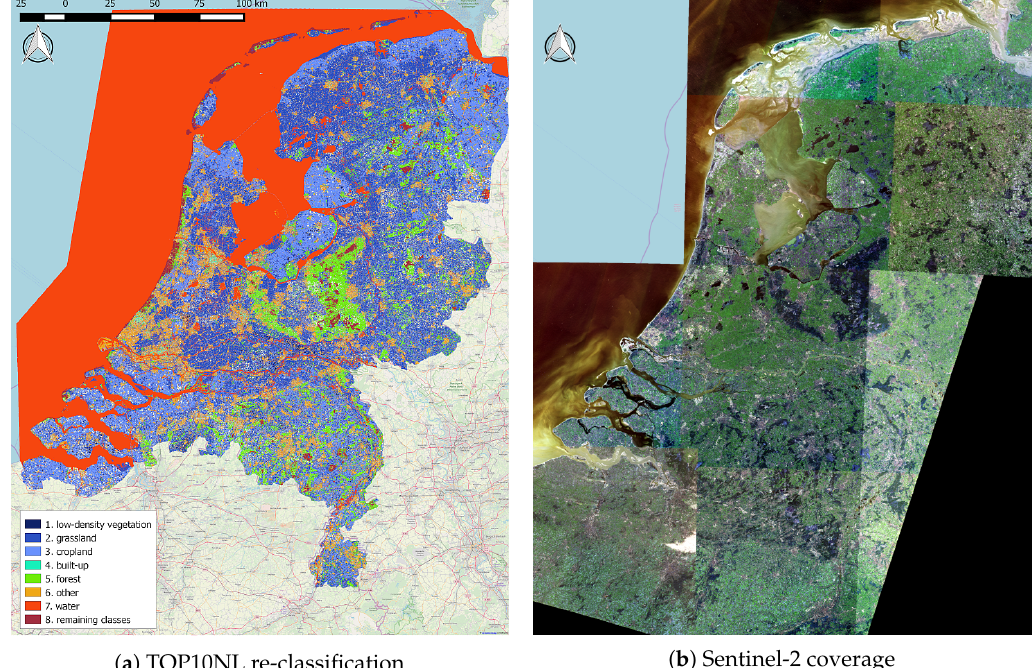
Figure 1. The re-classified (eight classes) rasterized version of the TOP10NL data set (42,508 km 2 , ∼ 550 M pixels) and the S2-coverage of the whole country of the Netherlands by one of the two Level-2A Sentinel-2